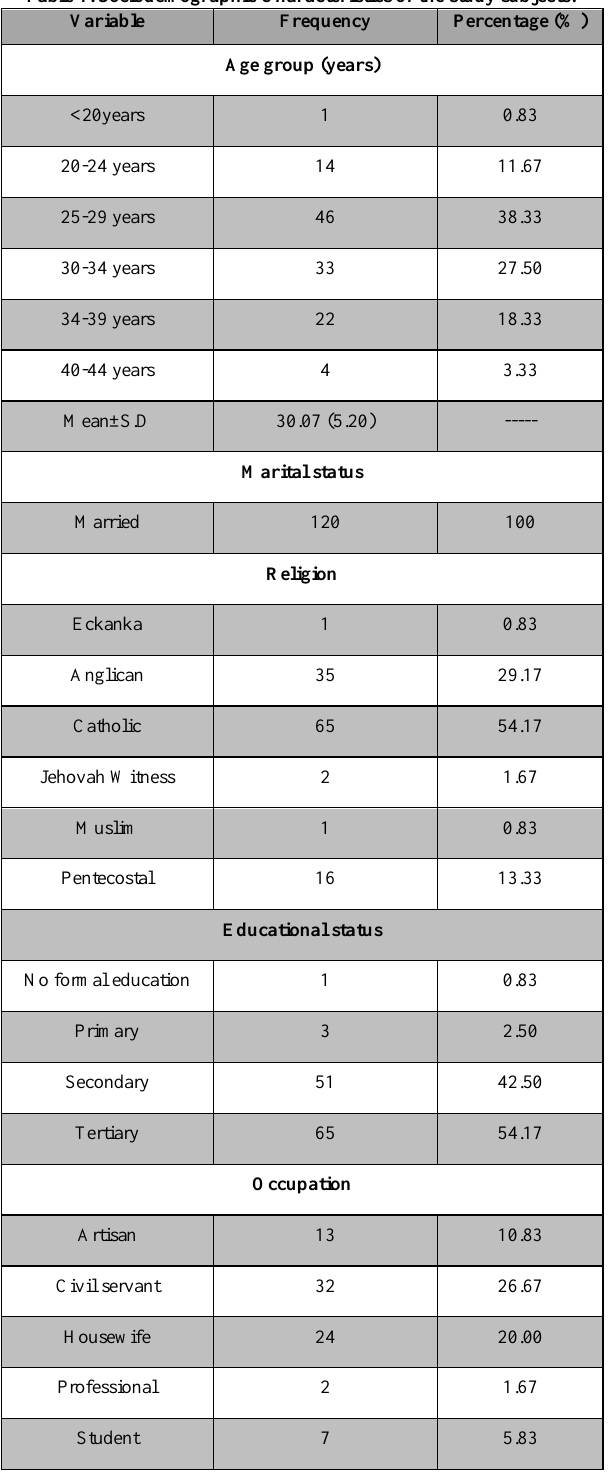
Table 1. Sociodemographic Characteristics of the study subjects.